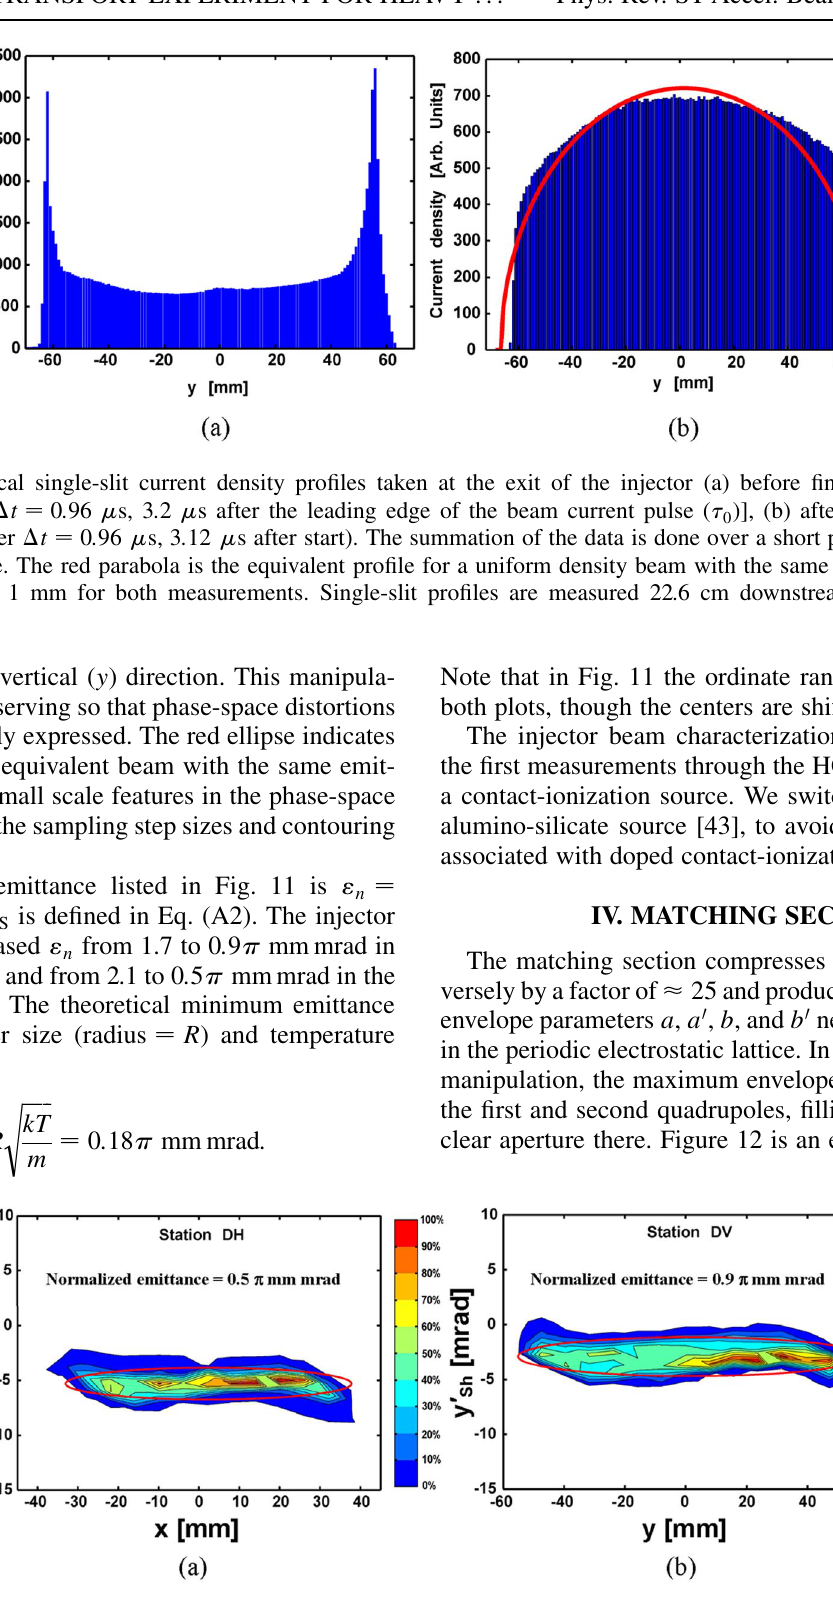
FIG. 11. (Color) Emittance diagrams (sheared) taken at the exit of the injector system after optimization of the injector diode. (a) x - x 0 (horizontal direction), (b) y - y 0 (vertical direction). Data shown here have been summed over eight time slices ( ( t (cid:5) 0 : 96 (cid:2) s ) ). The sampling step sizes are 6.2 mm and 0.9 mrad for the corresponding to the flattest part of the beam pulse ( 3 : 12 (cid:2) s after * 0 horizontal scan and 7.6 mm and 1.1 mrad for the vertical